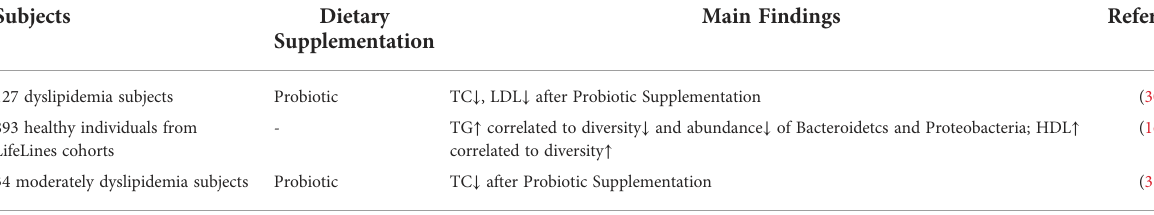
TABLE 2 Examples of recent association studies between lipid-related traits and gut microbiome in